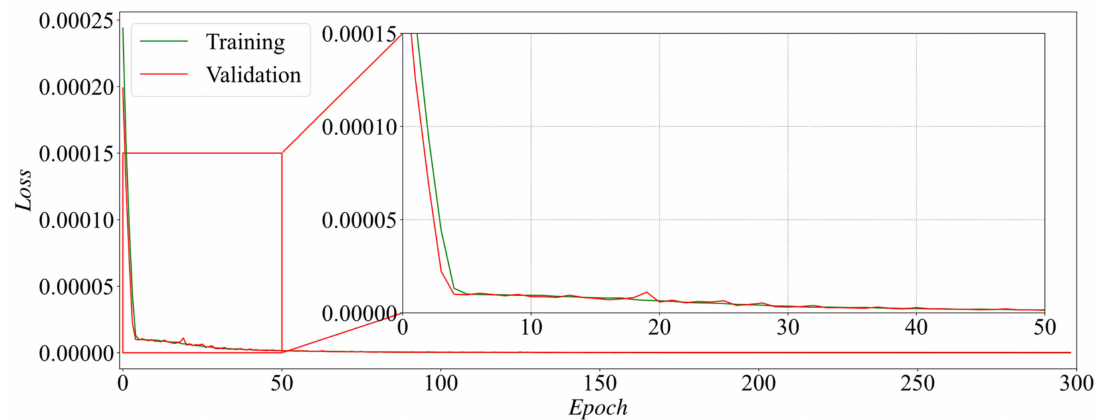
Figure 11. State prediction model loss trends for training and validation sets ( I m ).